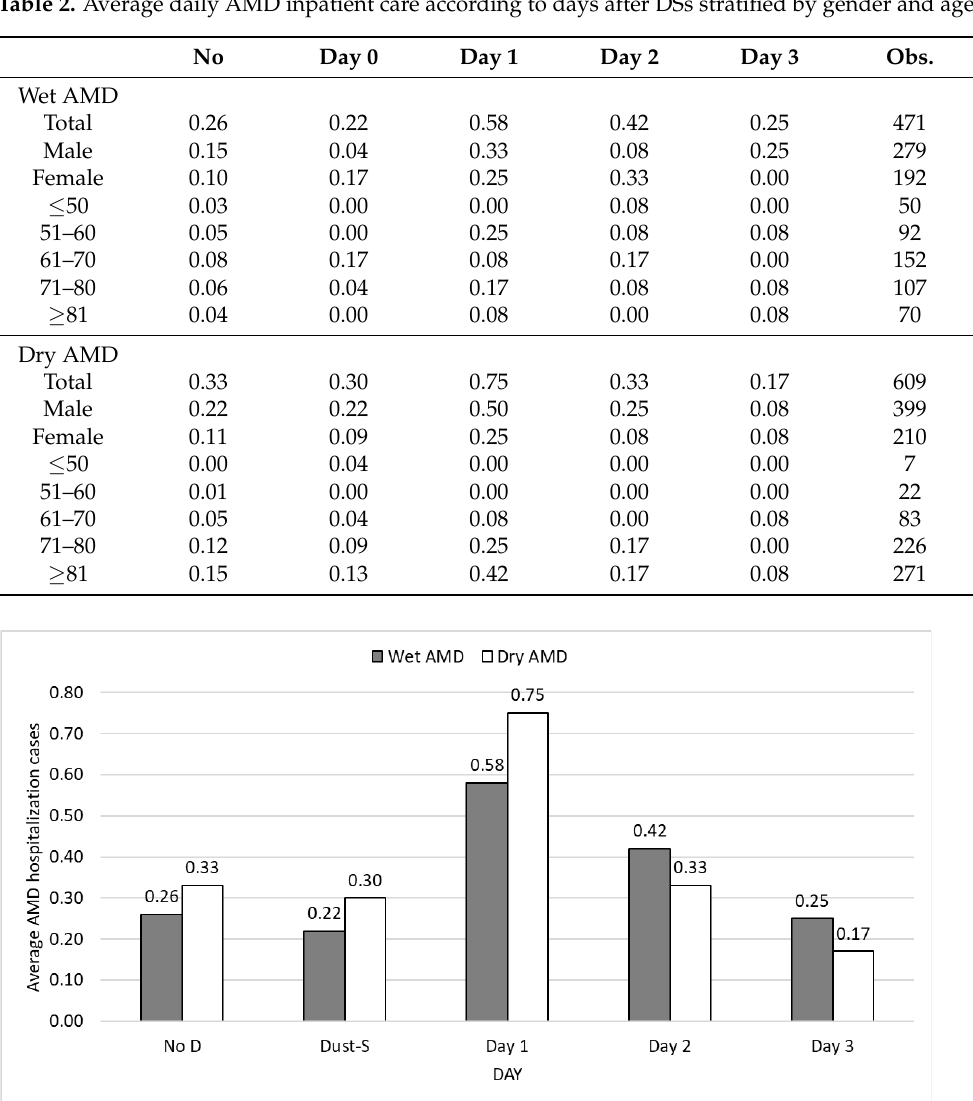
Figure 2. Average daily AMD inpatients according to days after dust storms, Taiwan, 2008–2012. Table 2 shows the trend of AMD inpatient care during DS events according to gender and age. Among 471 wet AMD inpatient cases, about 60% were attributed to males ( n = 279) with the ratio between males and females at 1.45:1.00. The average number of daily wet AMD inpatient cases on no-event days for males and females was 0.15 and 0.10, respectively. For males, the number of wet AMD inpatient cases increased to 0.33, 1 day after DSs (two times higher compared to no-event days). A considerable change was also observed for females before and after DS. The average numbers of daily AMD inpatient cases on no-dust days, dust event days, 1 day after DSs, and 2 days after DSs were 0.10, 0.17, 0.25, and 0.33, respectively. This indicates that wet AMD inpatient care increased with DS outbreaks for females. This study indicated a total of 609 dry AMD inpatient cases, where 399 cases were males (65.5%) and 210 were females (34.5%). For both males and females, the average number of dry AMD inpatient cases was double 1 day after DS onset, going from 0.22 and 0.11 to 0.50 and 0.25. This indicates that the risk of dry AMD hospital admission on day 1 after DSs was almost twofold greater than that on no-event days, regardless of gender.